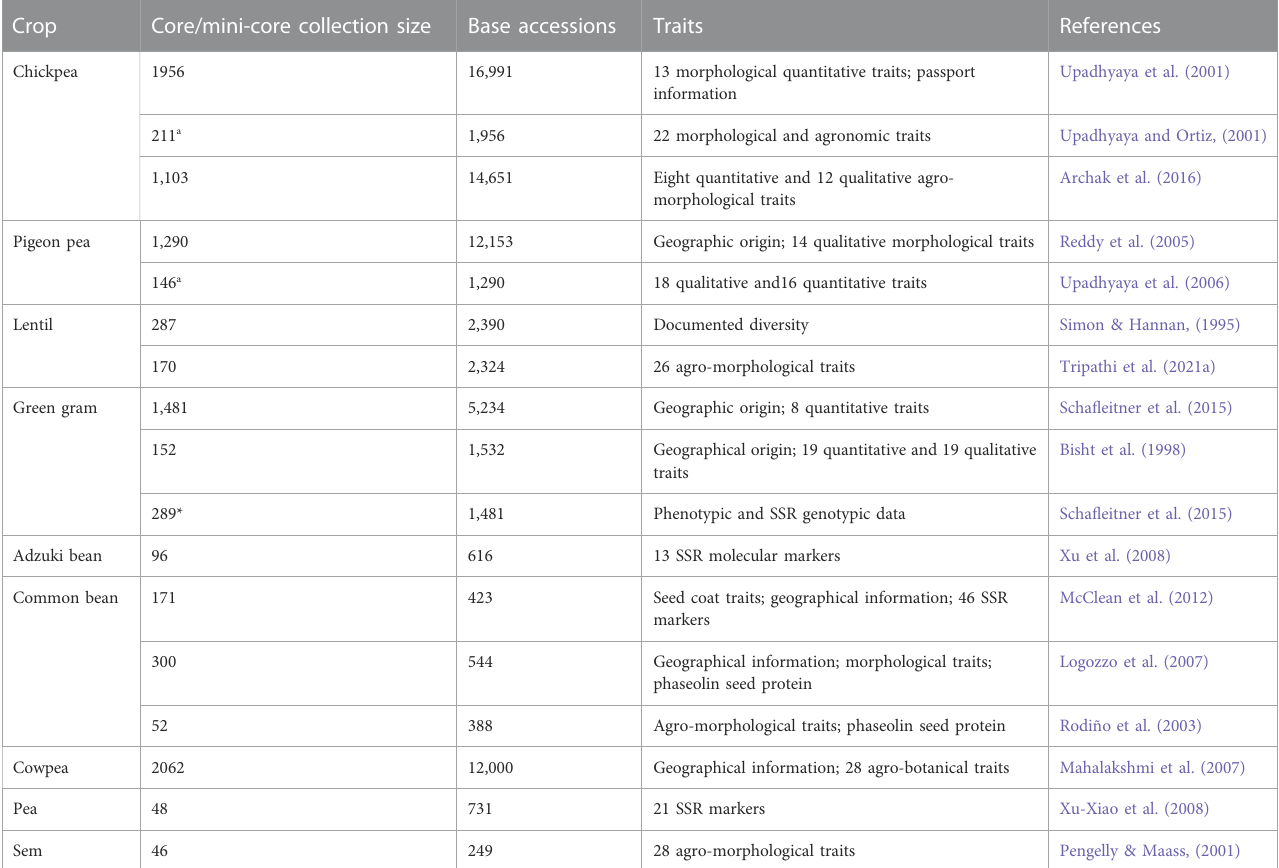
TABLE 3 List of core collections developed for grain legume